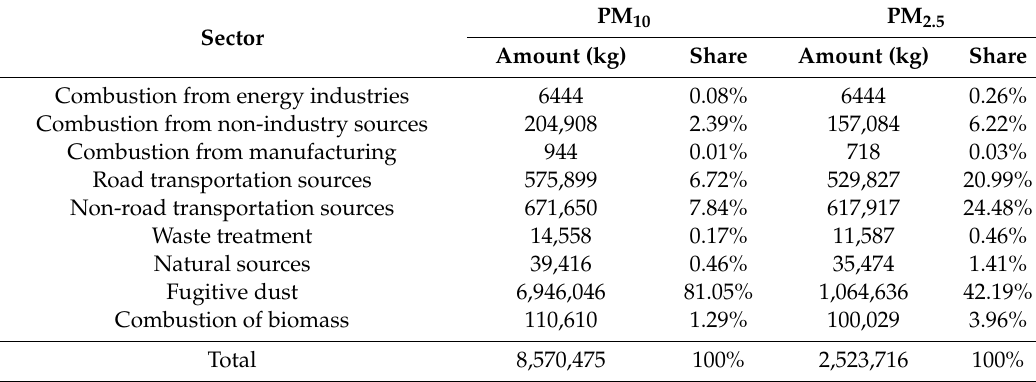
Table 1. Sector contributions to Seoul’s PM 10 and PM 2.5 concentrations in